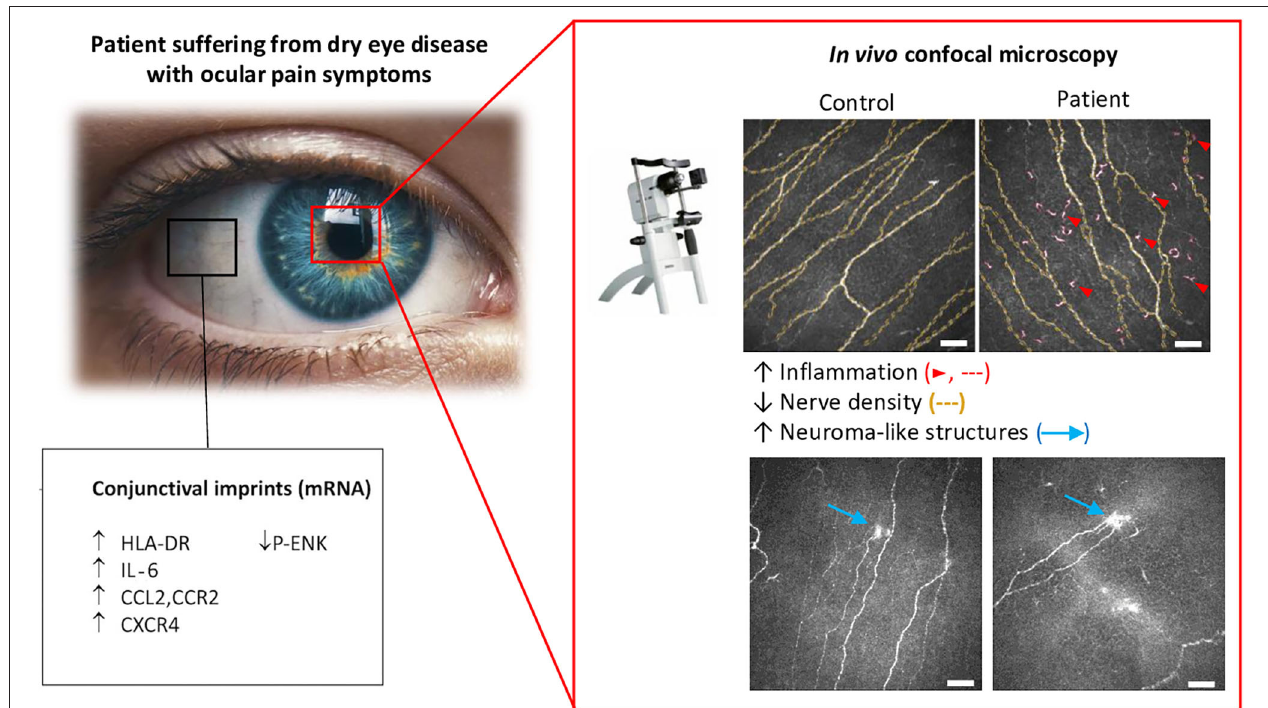
FIGURE 5 | Morphological and molecular changes in the ocular surface from dry eye patients with persistent ocular pain. Conjunctival imprints show higher levels of the proinflammatory markers, HLA-DR, IL-6, and CCL2, and of the chemokine receptors, CCR2 and CXCR4. In contrast, a decrease in the enkephalin precursor P-ENK was found in DE patients. Corneal IVCM imaging showed a decrease in nerve density, which was accompanied by a higher density of hyperreflective (putative inflammatory) cells and the presence of microneuroma-like structures in DED patients with pain syndromes. Modified from Nicolle et al.